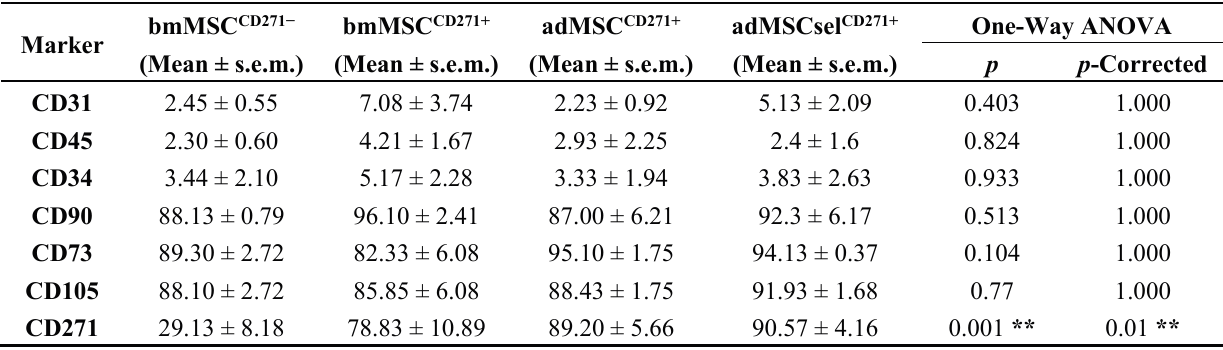
Table 1. Flow cytometry results showing the percentage of cells expressing typical markers of mesenchymal stem